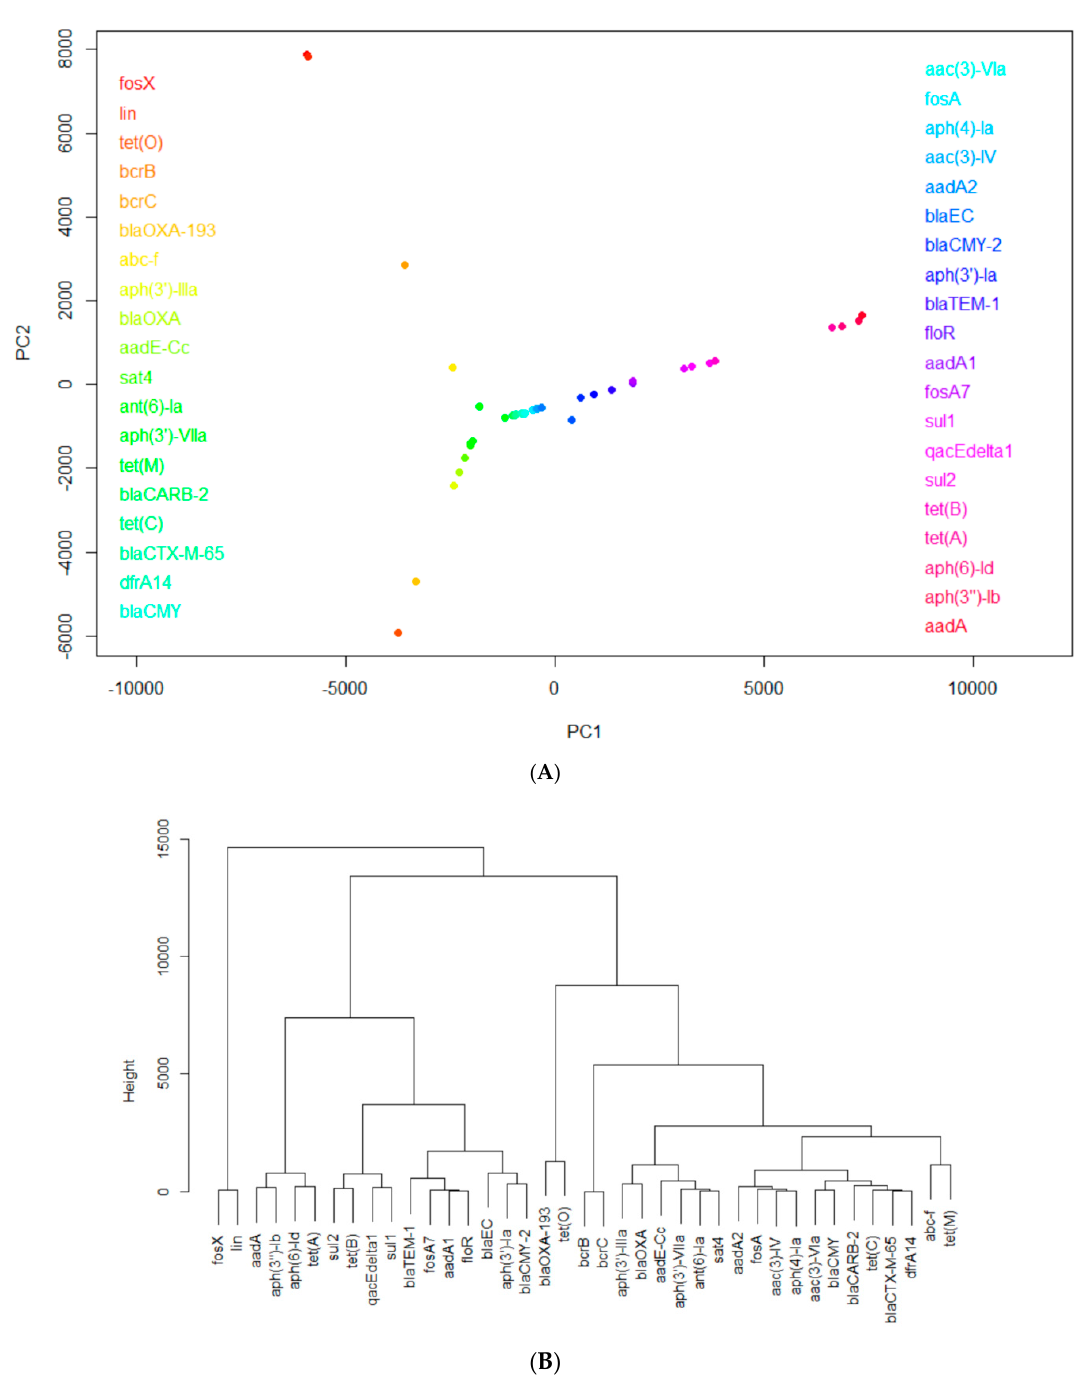
Figure 2. An illustrative example of PCA and hierarchical analysis: ( A ) projections of antimicrobial genes onto the PC1~PC2 space based on the occurrence of these genes detected in foodborne pathogens; ( B ) clustering of the genes based on their projections in ( A ).